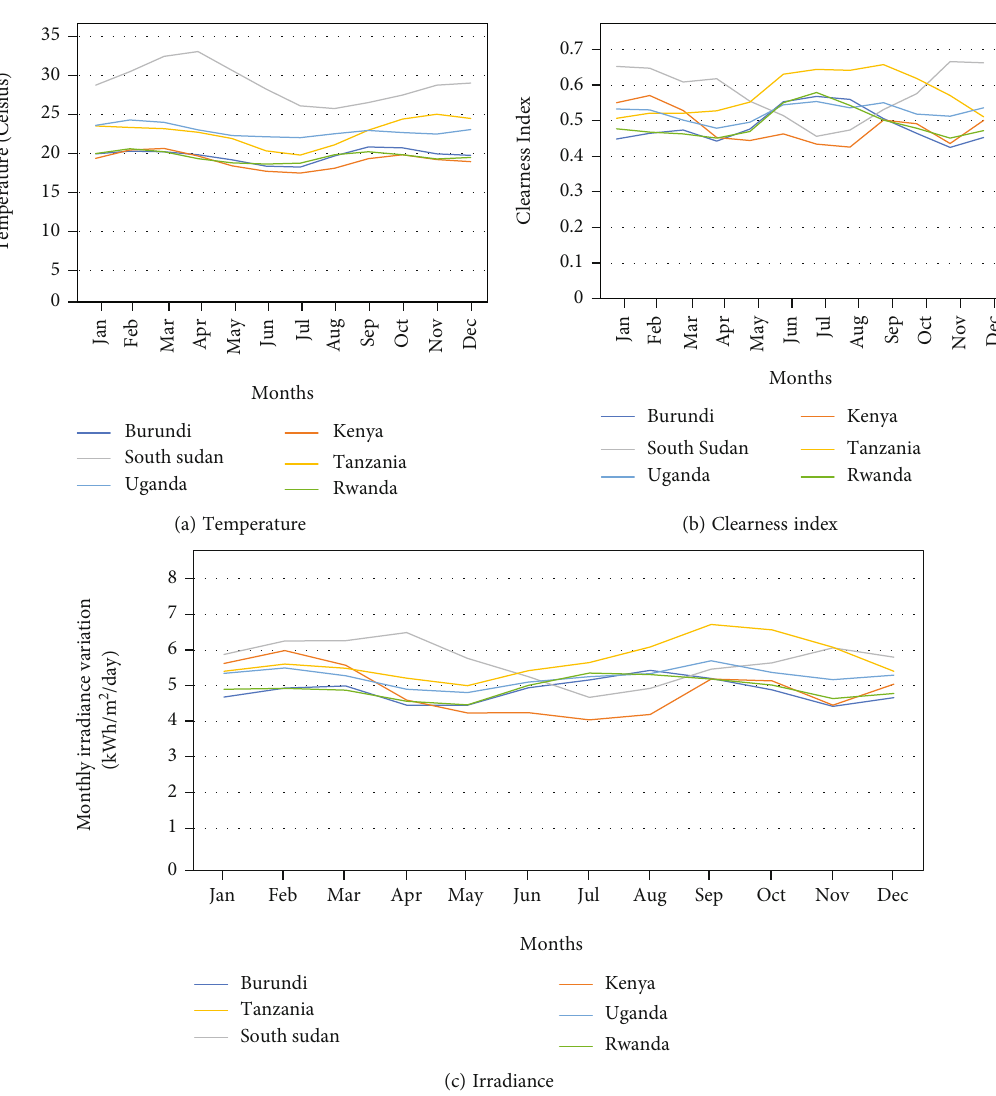
Figure 5: Climatic weather parameters (annual) for the six EAC